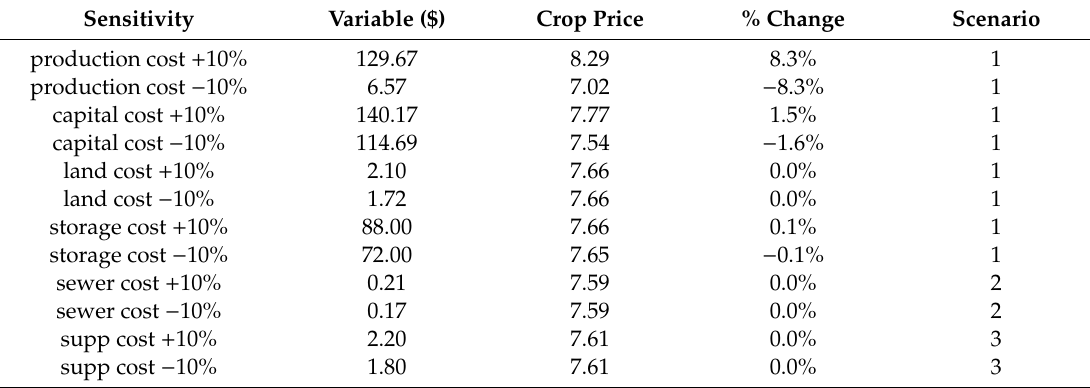
Table 6. Sensitivity of HYDRO-GH crop price to changes in economic inputs.